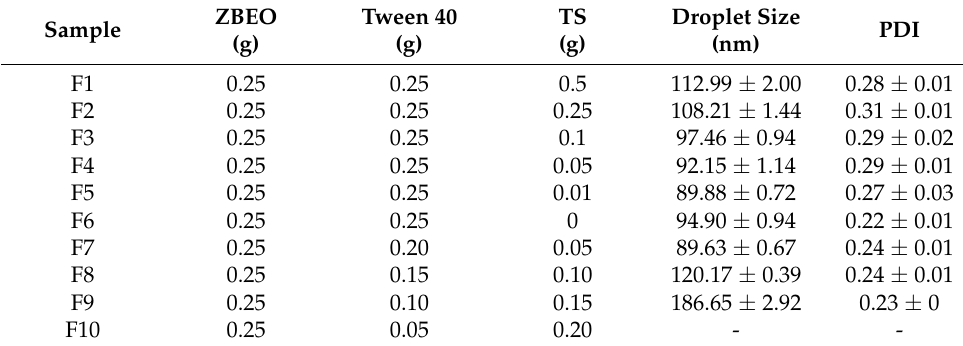
Table 2. Formulations of